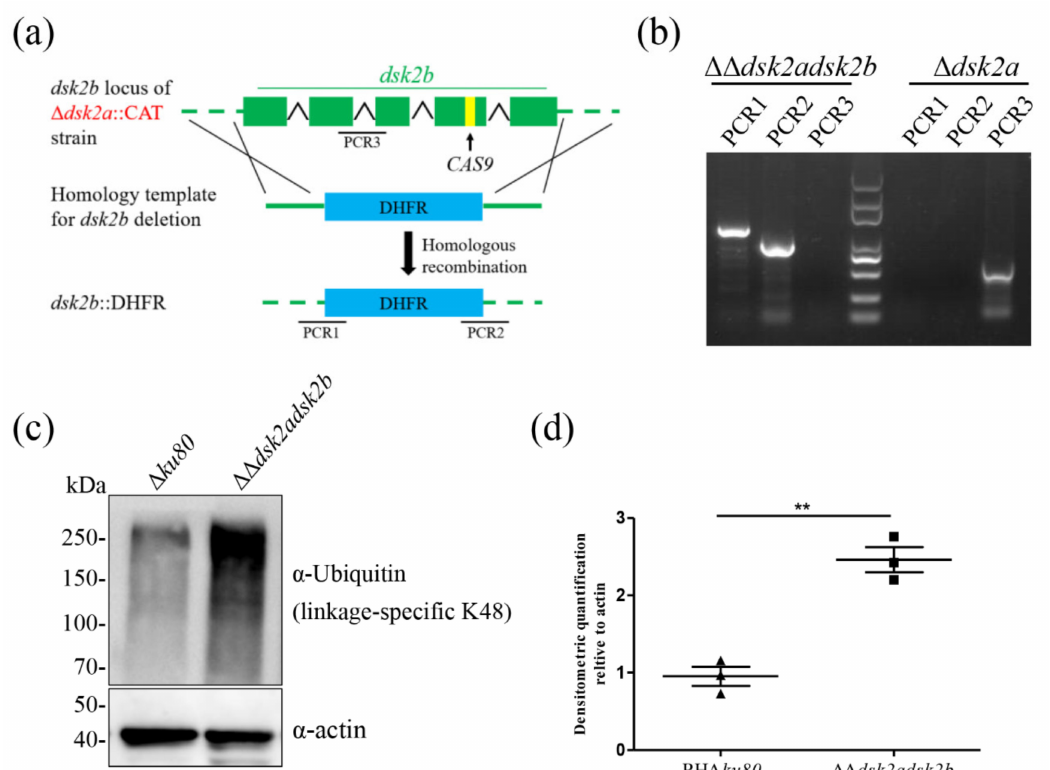
Figure 4. Deletion of DSK2s results in the accumulation of ubiquitinated proteins. ( a ) Schematic representation of ∆∆ dsk2adsk2b construction. The dsk2b gene locus in ∆ dsk2a:: CAT strain was replaced by DHFR cassette. ( b ) Diagnostic PCR of ∆∆ dsk2adsk2b construction. PCR1 and PCR2 were used to identify the homologous integration. PCR3 was used to amplify the fragment of dsk2b . ( c , d ) Western blotting determined the ubiquitinated proteins in ∆∆ dsk2adsk2b and ∆ ku80 . Ubiquitinated proteins were detected by rabbit anti-ubiquitin (linkage-specific K48) monoclonal antibody (upper panel). Actin served as a loading control (bottom panel). Graphs represent densitometric relative to actin. (mean ± SD from three biologically independent experiments). ** p <